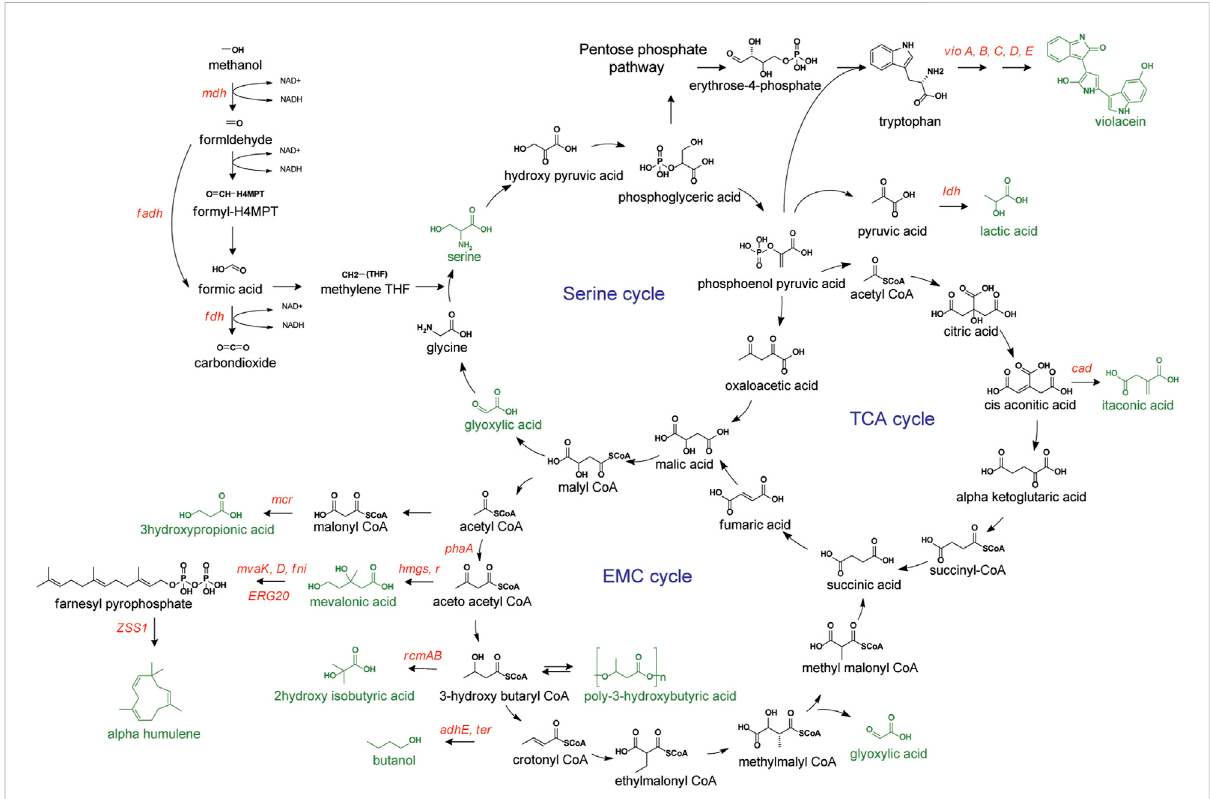
FIGURE 3 Methanol metabolism via Serine pathway. Targeted compounds represented in green. Overexpressed genes or enzymes are presented in red. mdh , methanol dehydrogenase; fl ds , formaldehyde dehydrogenase; fdh , formate dehydrogenase; mcr , malonyl-CoA reductase; mvaK, D , mevalonate kinase and decarboxylase; fni , isopentenyl-diphosphate delta-isomerase; ERG20 , farnesyl pyrophosphate synthase; ZZSl , α -humulene synthase; hmgs , hydroxymethylglutaryl-CoA synthase; hmgr , hydroxymethylglutaryl-CoA reductase; pha , thiolase; cad , cis